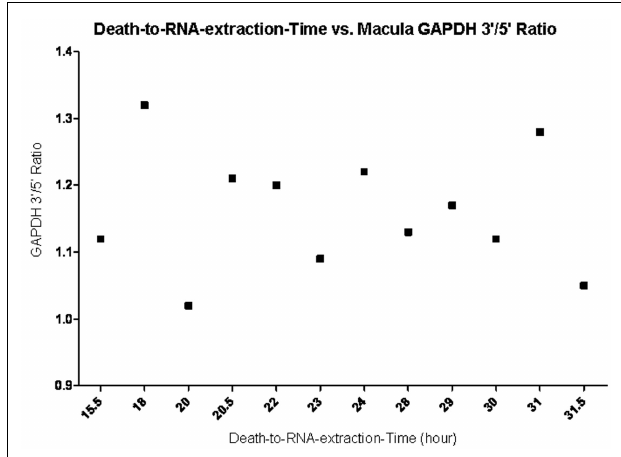
FIGURE 3 | Death-to-RNA-Extraction time vs. GAPDH 3 (cid:2) /5 (cid:2) ratio in macular tissue. Data shows no correlation between enucleation time and the quality of RNA (the closer the ratio is to 1, the better the RNA quality) within the 31.5h death-to-RNA-extraction time.